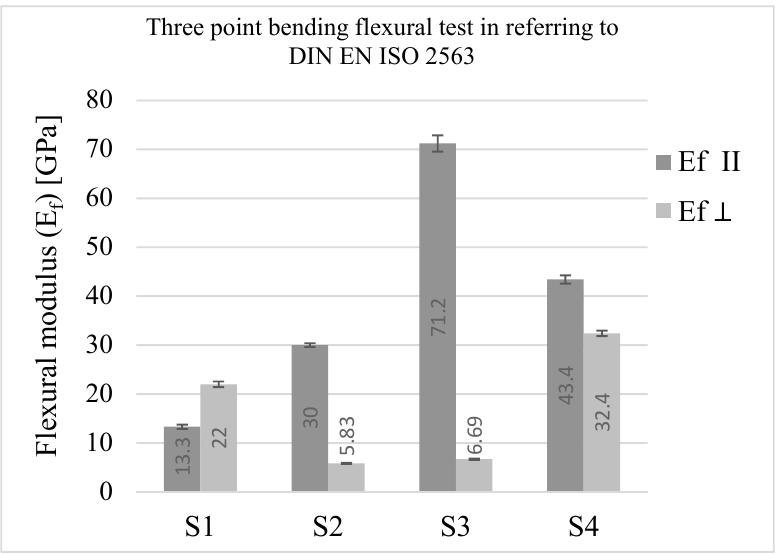
Figure 2. Flexural modulus E ƒ in the longitudinal and perpendicular directions of the main sample axis.